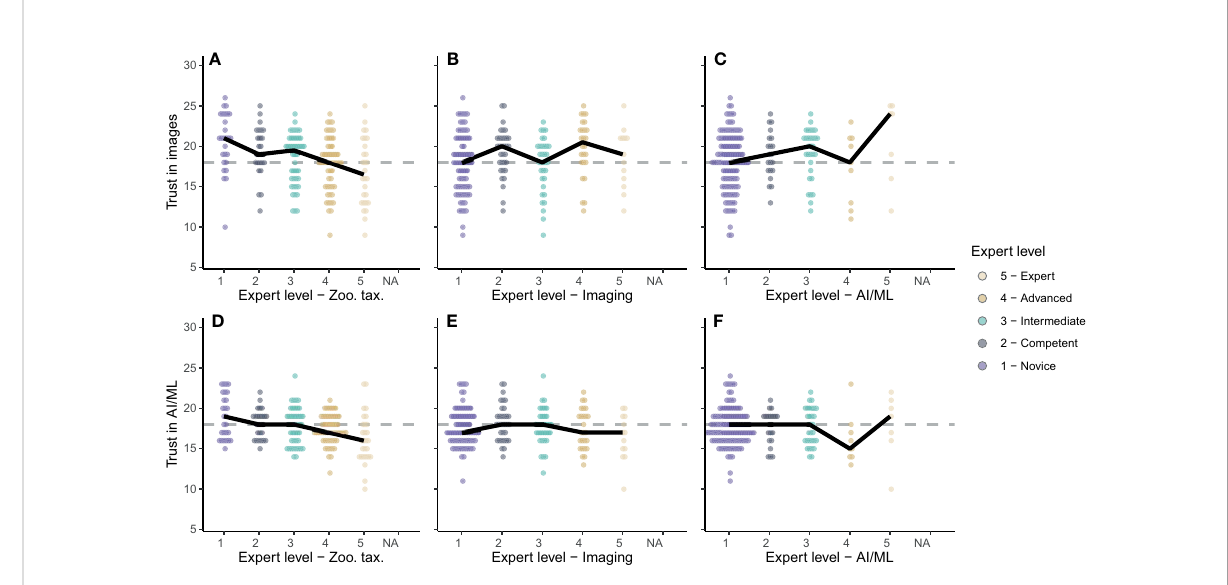
FIGURE 6 (A – C) Trust in images for zooplankton monitoring and (D – F) trust in AI/ML for zooplankton classi fi cation based on expertise in zooplankton taxonomy (A, D) , zooplankton imaging (B, E) and AI/ML (C, F) . Expert levels range from 1-Novice to 5-Expert as shown in the legend. Dots show the individual scores for each survey participant. Solid black lines connect the medians for each expert